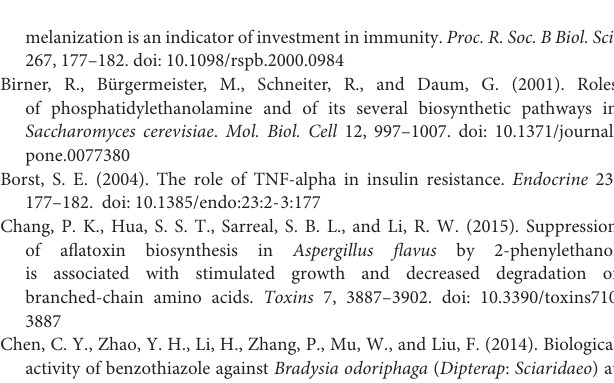
FIGURE S3 | Venn diagram of the DEGs in five signaling pathways at 6 h in Bradysia odoriphaga , highlighting core signaling genes. TABLE S1 | Primers used in the current study for RT-qPCR. TABLE S2 | Summary of RNA-seq reads mapped to the Botrytis cinerea B05.10 genome. TABLE S3 | Differentially expressed genes identified in Botrytis cinerea exposed to benzothiazole for 12, 24 and 48 h. TABLE S4 | The 28 core genes shared by the 12, 24 and 48 h comparison groups ( Figure 3B ) identified in the Botrytis cinerea transcriptome. TABLE S5 | Detailed information for the overlapping DEGs involved in the two pathways shared by the 24 and 48 h groups ( Figure 5B ) in the Botrytis cinerea transcriptome.